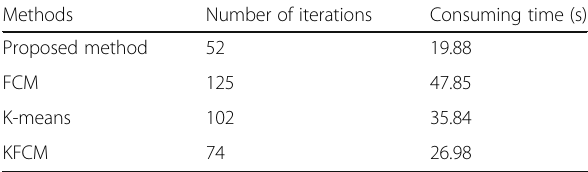
Table 2 Consuming time comparison of different methods